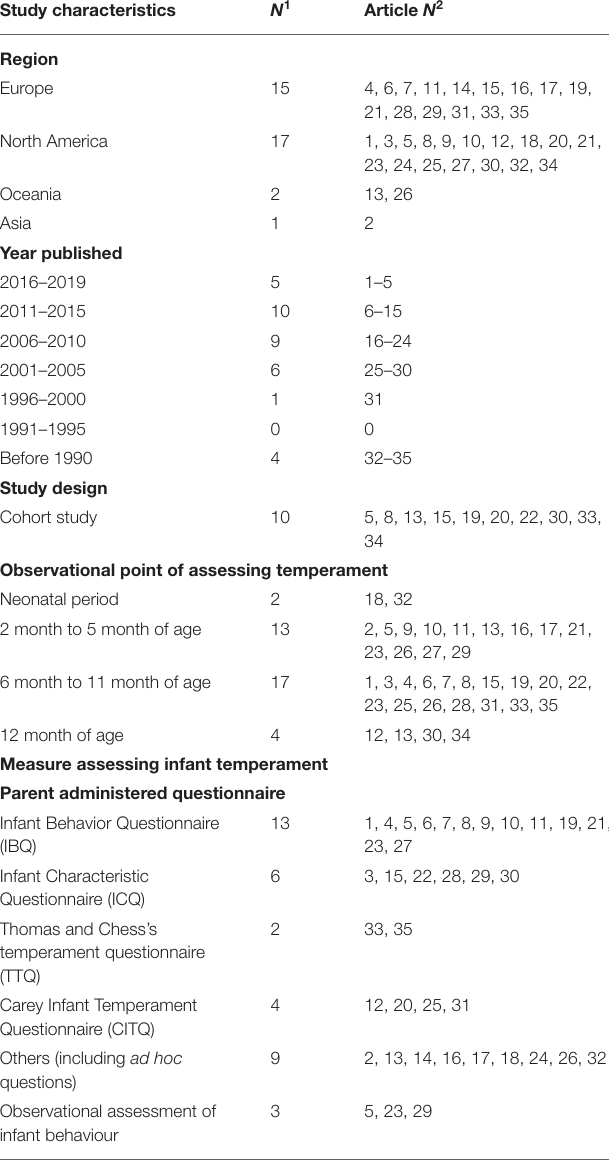
TABLE 1 | Study characteristics of